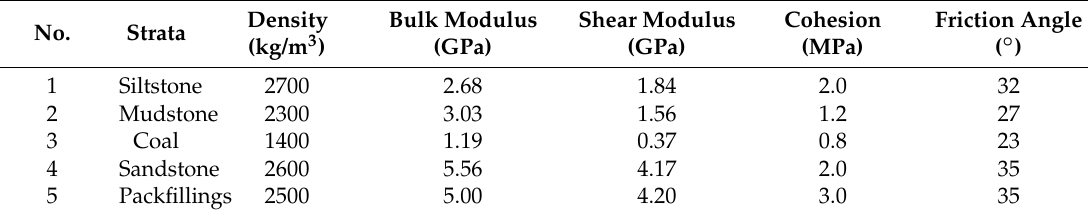
Figure 6. Plan view of the simulated area ( a ); and 3D dimensions of the model ( b ). Table 1. Mechanics parameters of the rock mass used in simulation [24].